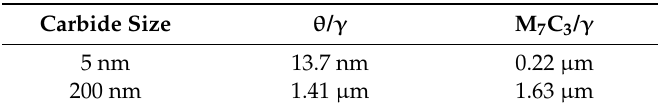
Table 4. Diffusion distance for carbon at 950 ◦ C for cementite ( θ ) and M 7 C 3 carbide for fine and coarse